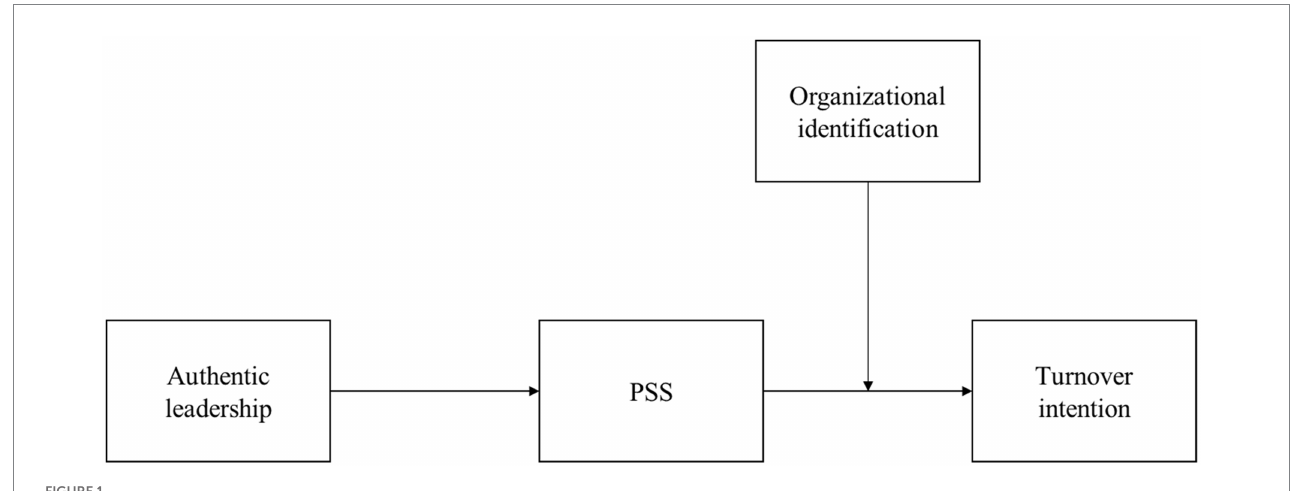
FIGURE 1 Proposed research